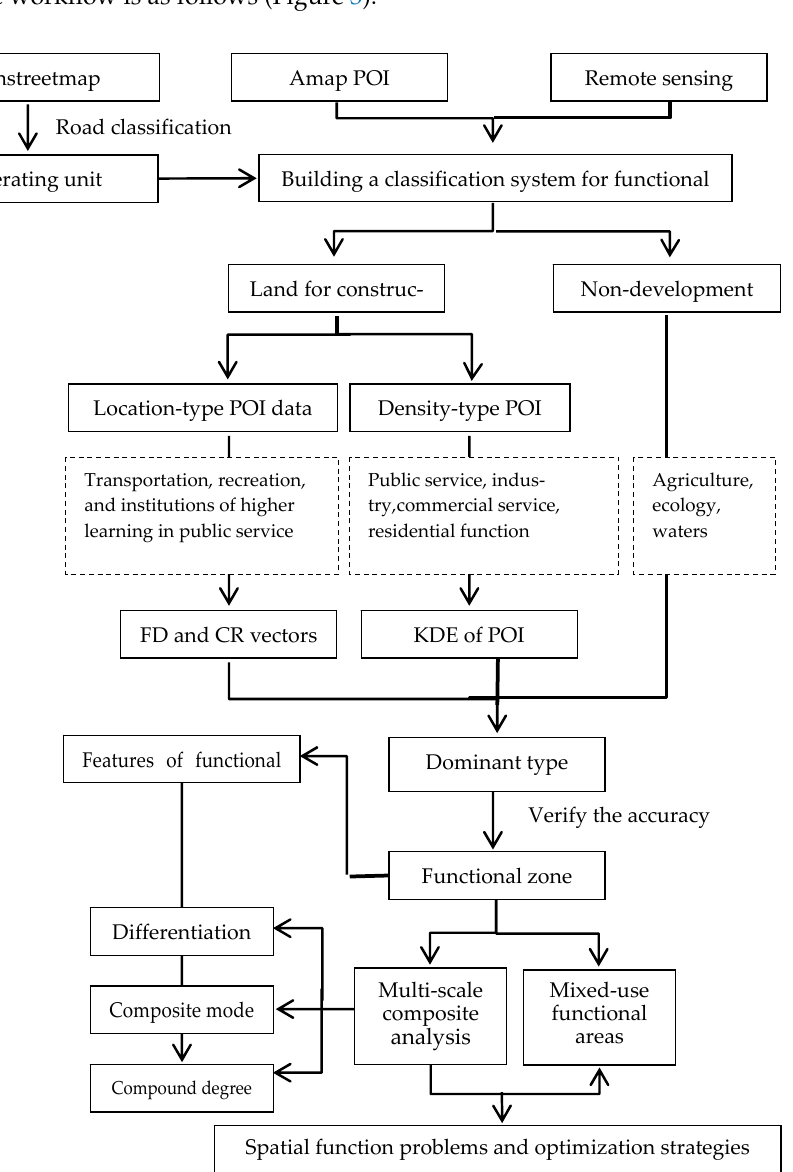
Figure 3. Functional space identification process of the Dujiangyan Irrigation District.